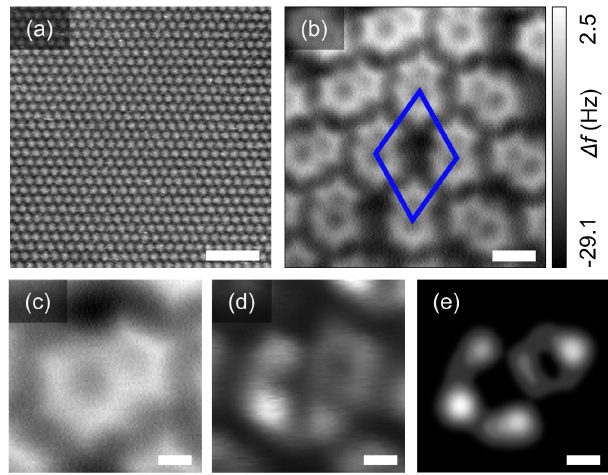
FIG. 6. STM and nc-AFM images of azulene on Cu(111). (a) Large-scale STM image of azulene on Cu(111), commensu- ffiffiffi p ffiffiffi p 3 3 Þ -R30° structure (0.65 ML), I ¼ − 0 . 06 nA rate ð 2 × 2 t U ¼ − 1 . 28 V, scale bar ¼ 5 nm. (b) nc-AFM image of azulene t on Cu(111), partially compressed phase (total coverage ffiffiffi p ffiffiffi p 3 3 Þ -R30° 0.78 ML), with an overlaid unit cell of the ð 2 × 2 structure, scale bar ¼ 0 . 5 nm. Note the disordered structure with higher density around the central unit cell of the commensurate structure. (c) nc-AFM image of an azulene molecule, (d) corre- sponding STM constant-height image, (e) DFT Tersoff-Hamann simulation of azulene adsorbed on Cu(111) within an energy range of 0 to 0.1 V below E . Scale bar for ð c-e Þ ¼ 0 . 1 F